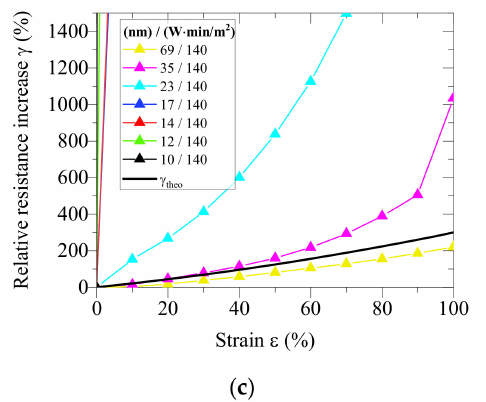
Figure 6. Increase in resistance under strain for PET films pretreated with di ff erent corona dosages: ( a ) 0; ( b ) 70; ( c ) 140; ( d ) 210 and ( e ) 280 W · min / m 2 . Colored lines in each graph represent di ff erent aluminum thicknesses ranging from 10 to 69 nm. The y -axis scales vary by a factor of up to 10 3 . Each value is a mean of n = 5 measurements.